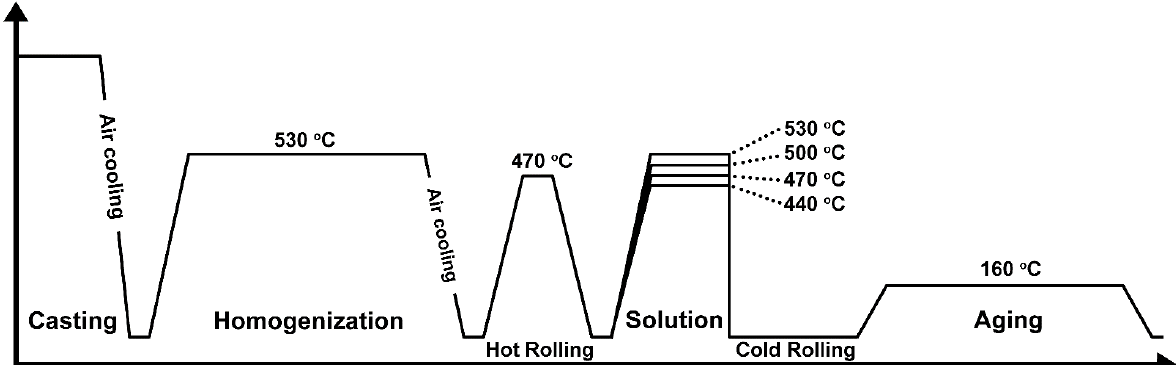
Figure 2. Schematic diagram of the applied tempering process .